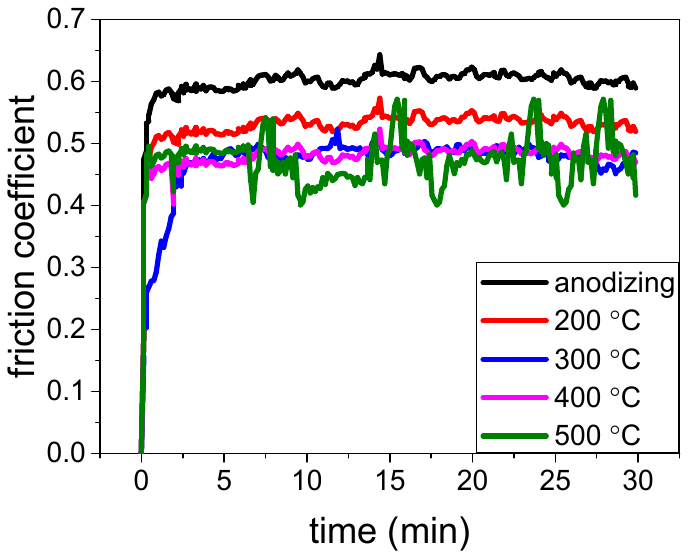
Figure 8. Friction coefficient of Al-alloy, anodic coating before and after being treated by hydro- thermal technology at 200 °C, 300 °C, 400 °C and 500 °C.